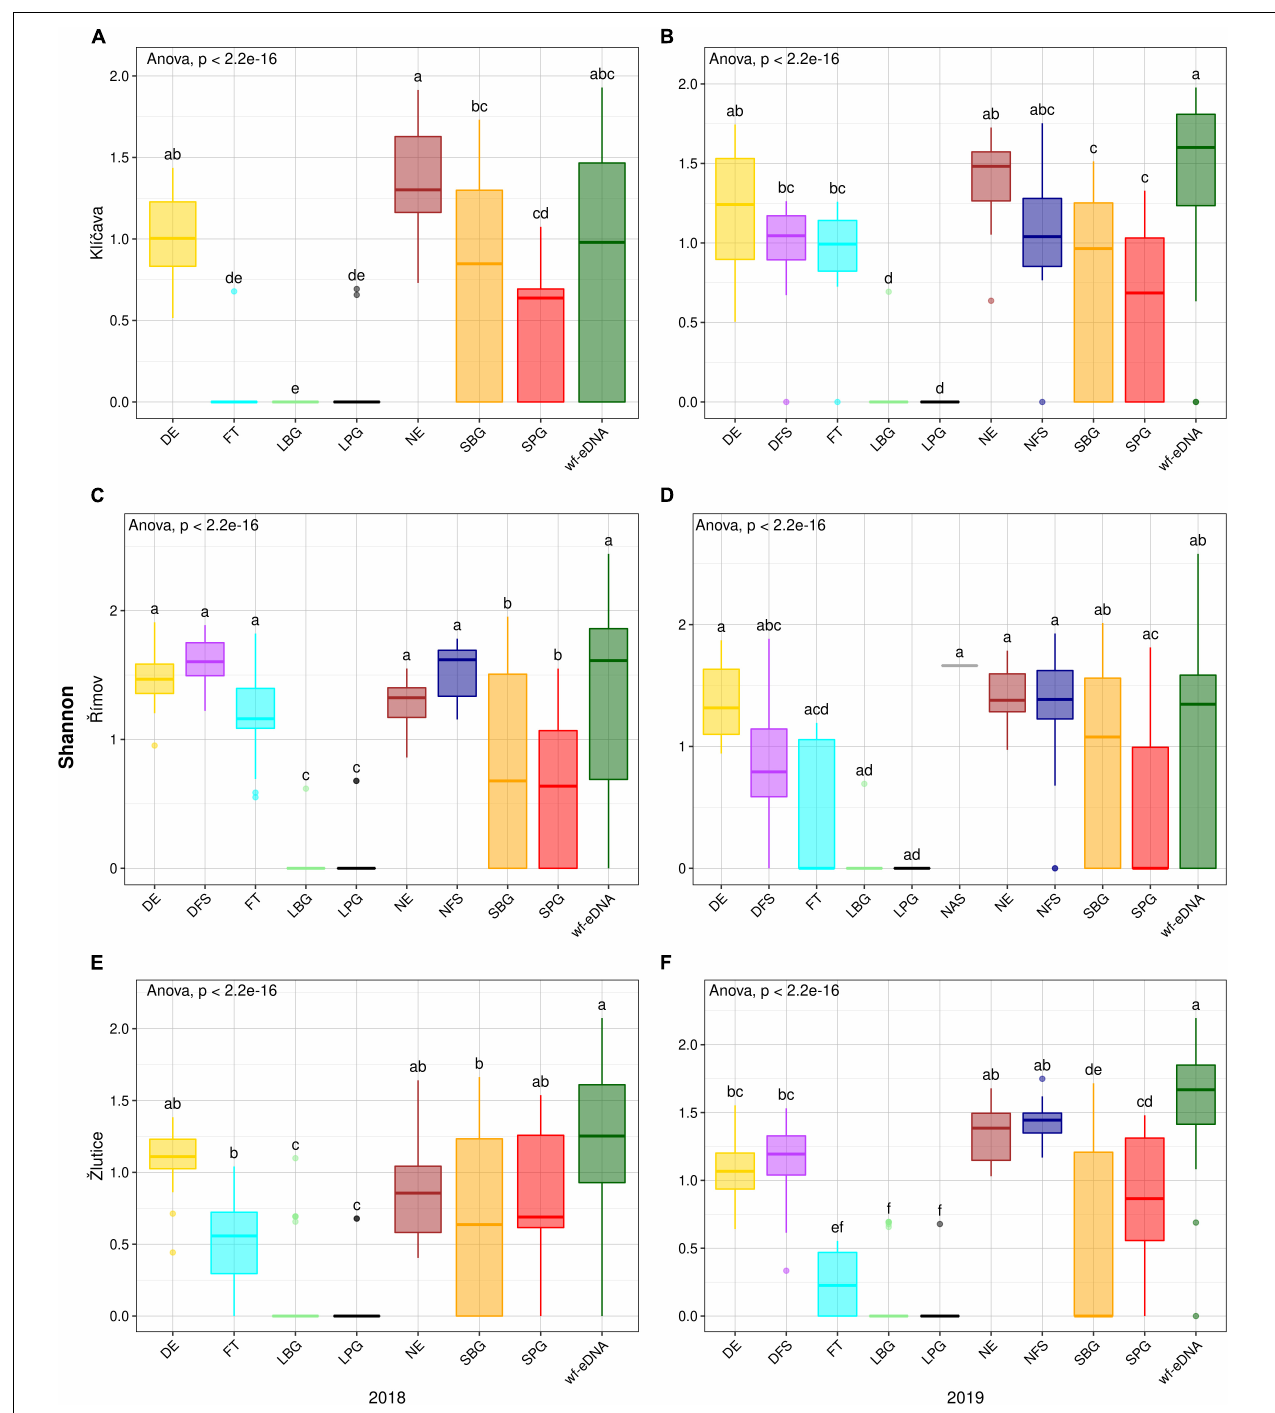
FIGURE 4 | Box plots comparison of alpha diversity (Shannon) based on CPUE data in 2018 (left plots) and 2019 (right plots) between wf-eDNA assay and traditional sampling methods in Klíˇcava, ˇRímov and Žlutice reservoirs. Significant differences are indicated by different superscripts. Horizontal line inside the box indicates the calculated median, box 1st and 3rd quartile, whiskers data range and dots outliers of Shannon value. Traditional sampling methods are abbreviated as follow: DE = day electrofishing, NE = night electrofishing, SBG = standard benthic gillnets, SPG = standard pelagic gillnets, LBG = large mesh-size benthic gillnets, LPG = large mesh-size pelagic gillnets, NAS = night-time adult seining, DFS = day-time fry seining, NFS= night-time fry seining, FT = fry trawl and wf-eDNA = eDNA from water targeting fish.